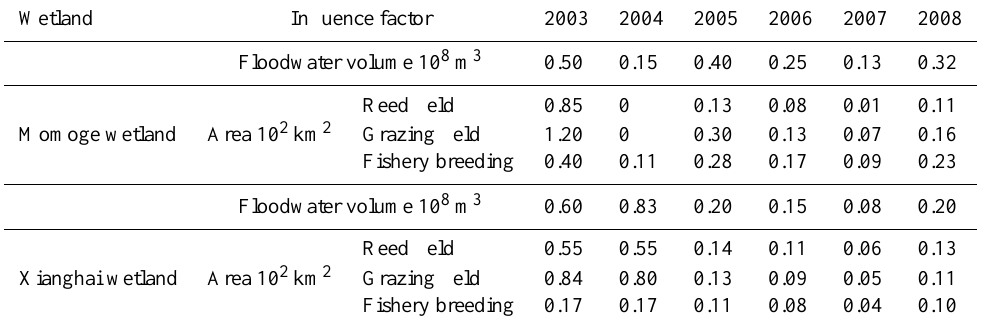
Table 2. Wetland services and functions evaluated in this study. Type Value Services Functions Direct value Economic value Goods production Production of reeds, grazing and fish Gas regulation Carbon fixation, oxygen supply and greenhouse effect Flood Mitigation Water retention and storage Indirect value Eco-environmental value Water purification Waste treatment and pollution